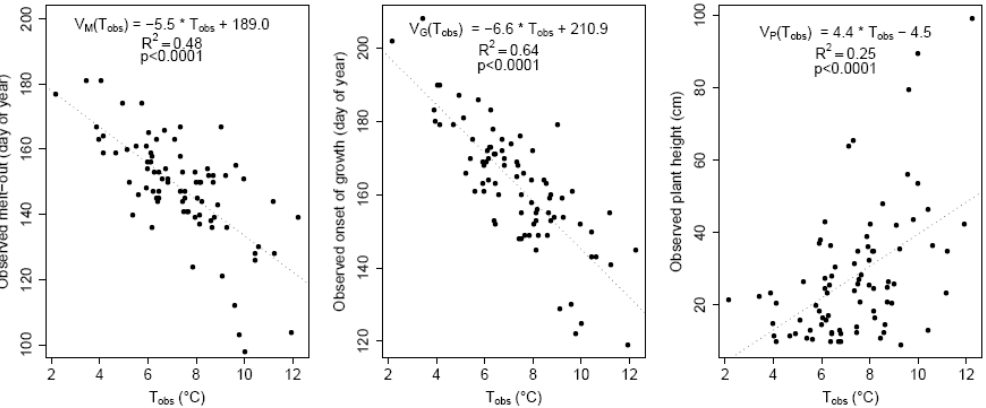
Figure 2 Fig. 2. Regression models for predicting melt out ( V M ), onset of growth ( V G ) and plant height ( V P ) from measured May/June-mean temperature ( T obs ) for the current period 1997–2005.